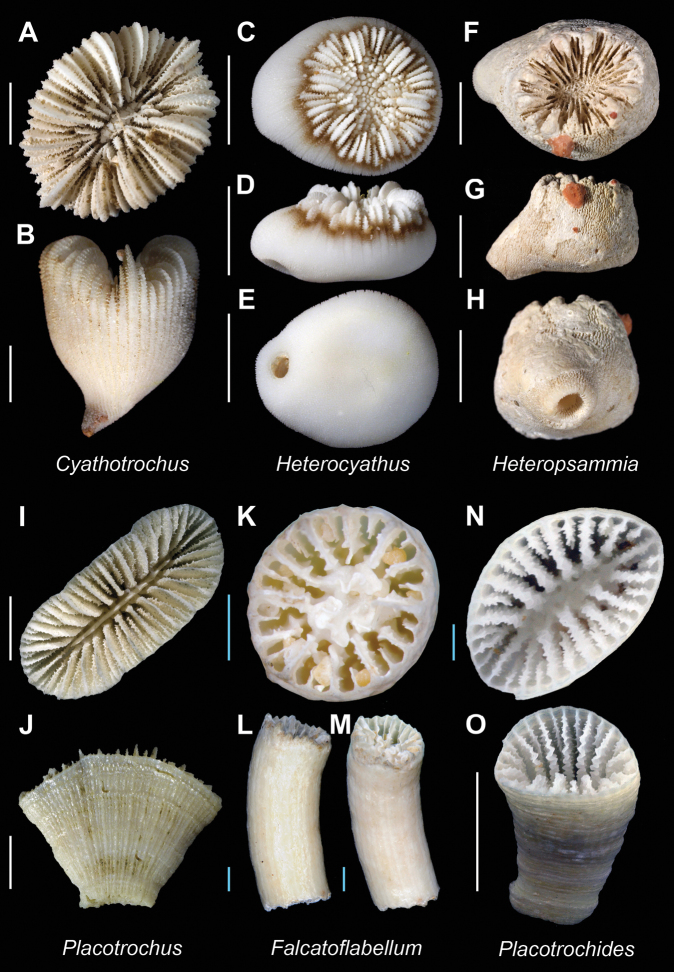
Cyathotrochus pileus(USNM uncatalogued, Bathus 3 stn. CP833) A and B Calicular and lateral view respectively; Heterocyathus aequicostatus(USNM uncatalogued, Bathus 4 stn. DW933) C, D, and E Calicular, lateral, and base view respectively; Heteropsammia cochlea(USNM uncatalogued, Bathus 3 stn. DW894)F, G, and H Calicular, lateral, and base view respectively; Placotrochus laevis(USNM 81989) I and J Calicular and lateral view respectively; Falcatoflabellum raoulensis(MNHN uncatalogued, Ebisco stn. DW2603) K, L, and M Calicular, lateral, and oblique view respectively; Placotrochides scaphula(MNHN uncatalogued, Chalcal stn. DW75) N and O Calicular and oblique view respectively. Scale bars: blue = 1 mm; white = 5 mm. Bold face indicates type species for the genus.